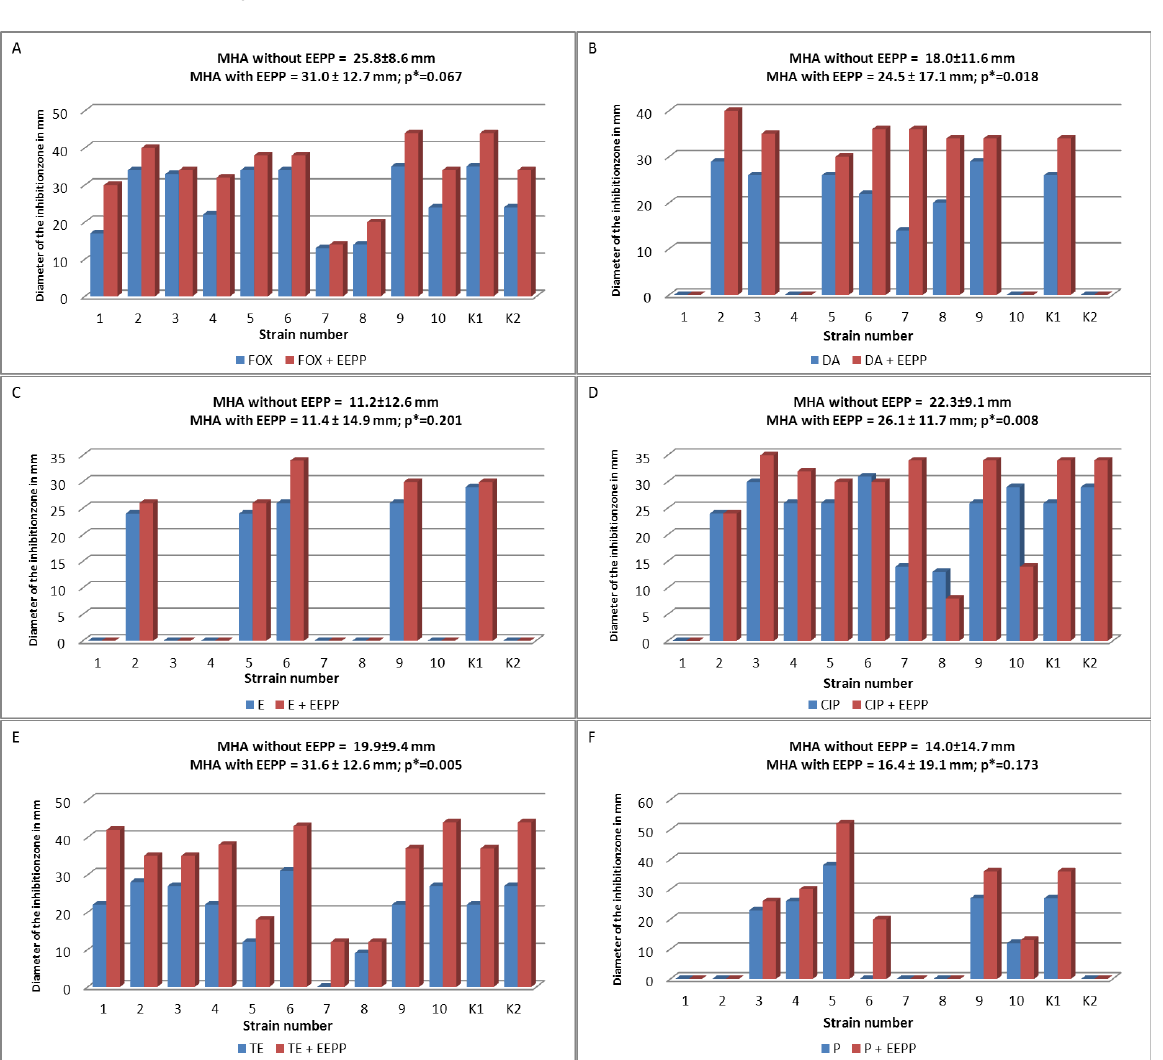
on 12 Staphylococcus strains evaluated by disk diffusion method. ( A ) FOX